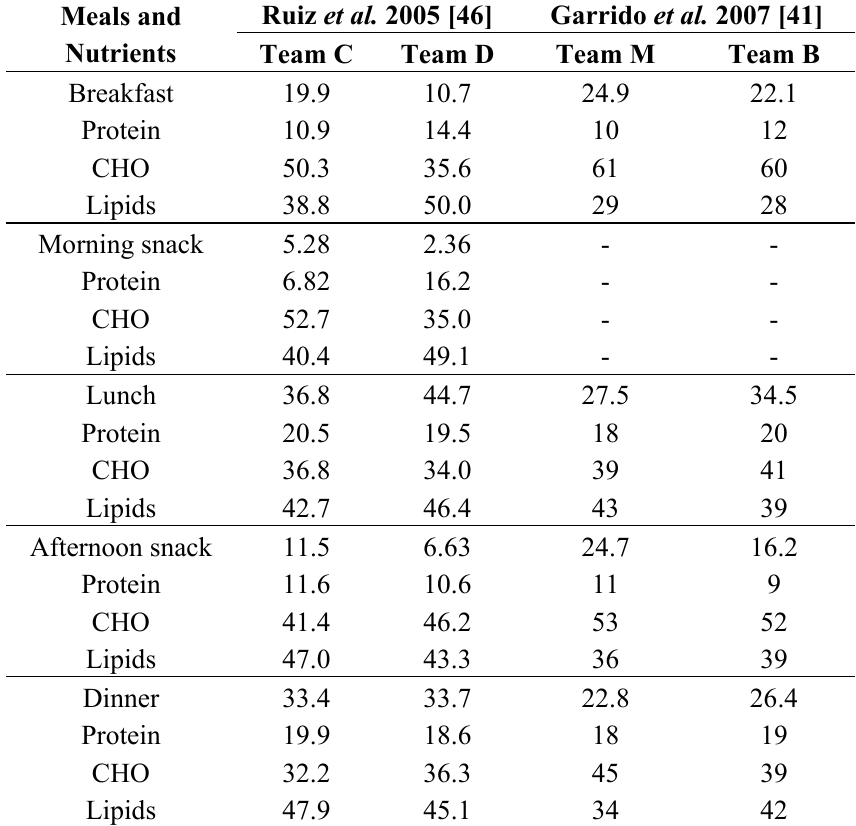
Table 3. Studies examining the distribution of energy intake (%) across different meals and the proportion of energy intake (%) provided by the different macronutrients at each